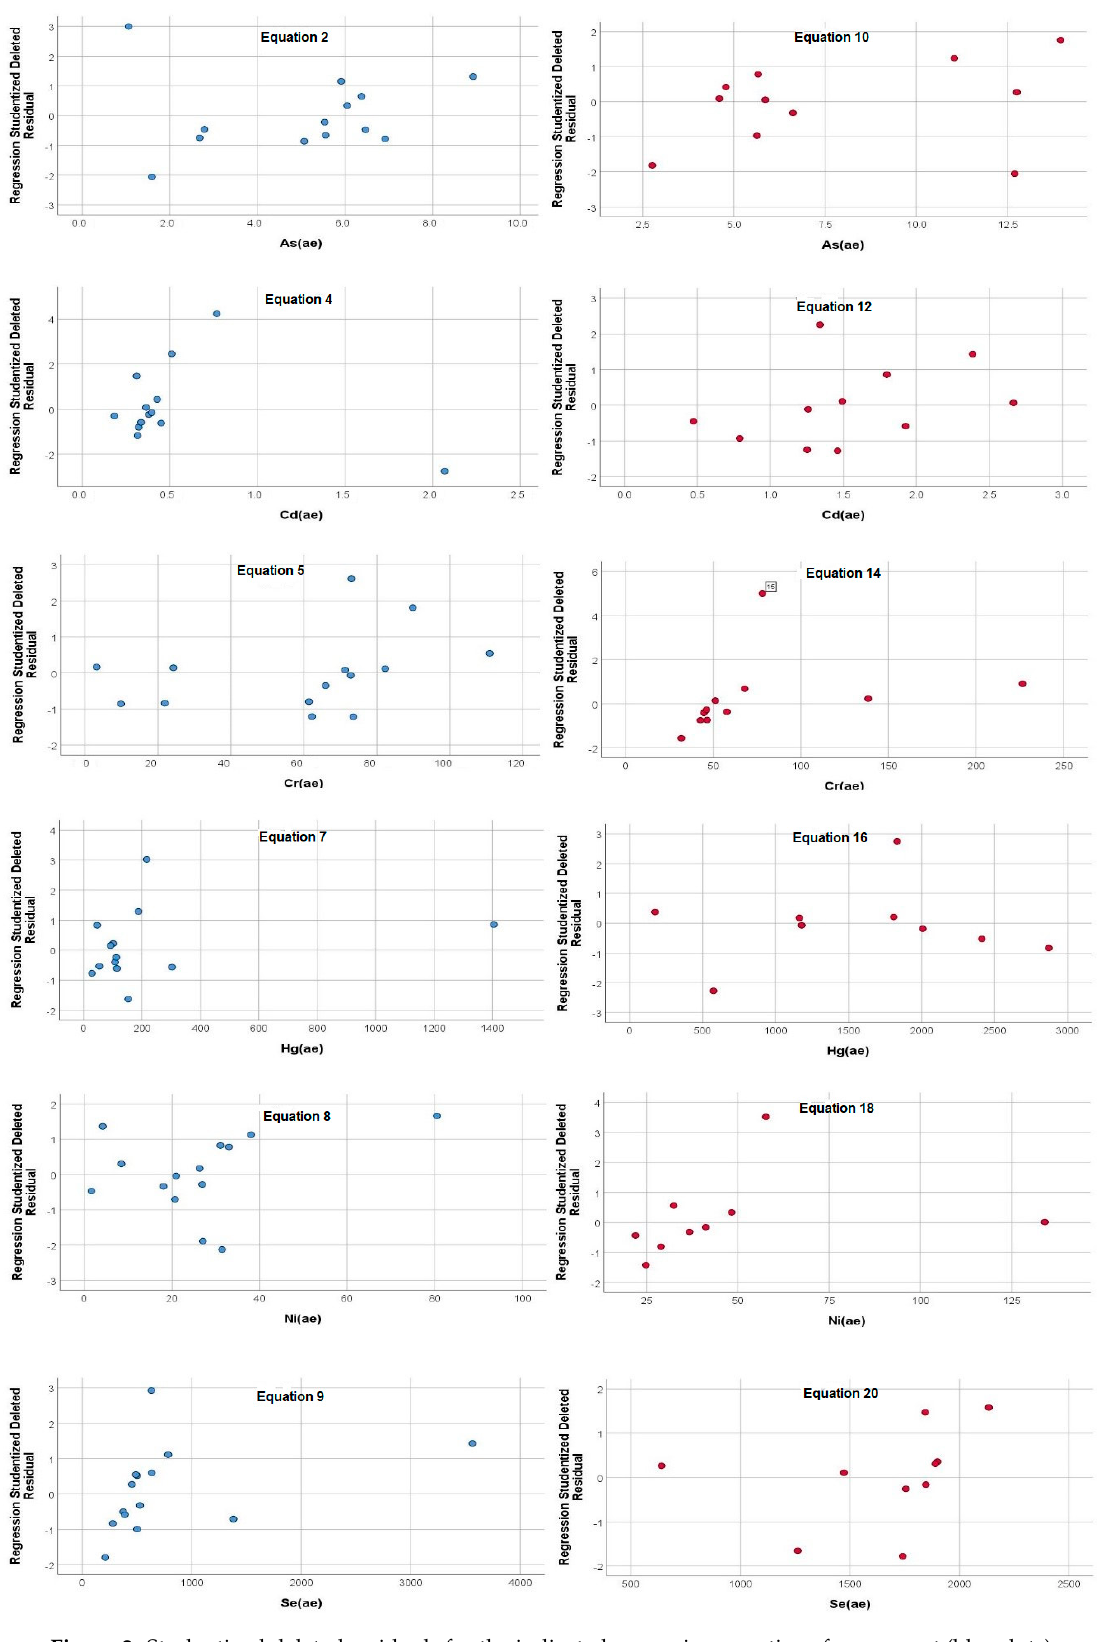
Figure 2. Studentized deleted residuals for the indicated regression equations for compost (blue dots) and 4 for sewage sludge (red dots).